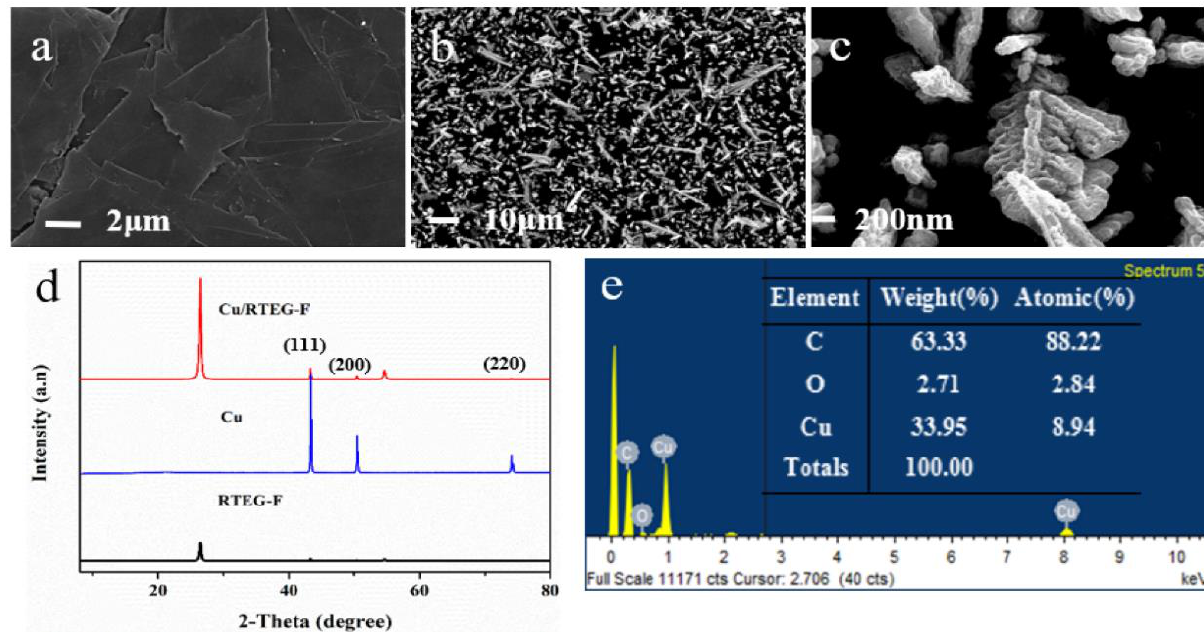
Figure 1. SEM images of ( a ) pure RTEG-F and ( b , c ) Cu/RTEG-F at a deposition time of 8 min. ( d ) XRD pattern of Cu/RTEG-F. ( e ) The EDS pattern and elemental contents of Cu/RTEG-F.